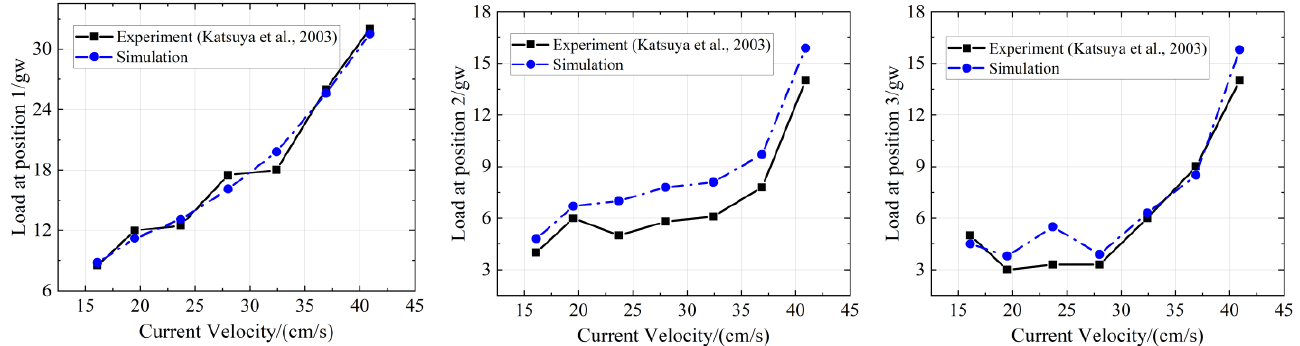
Figure 9. The comparison of the tension loads of net type A [36].